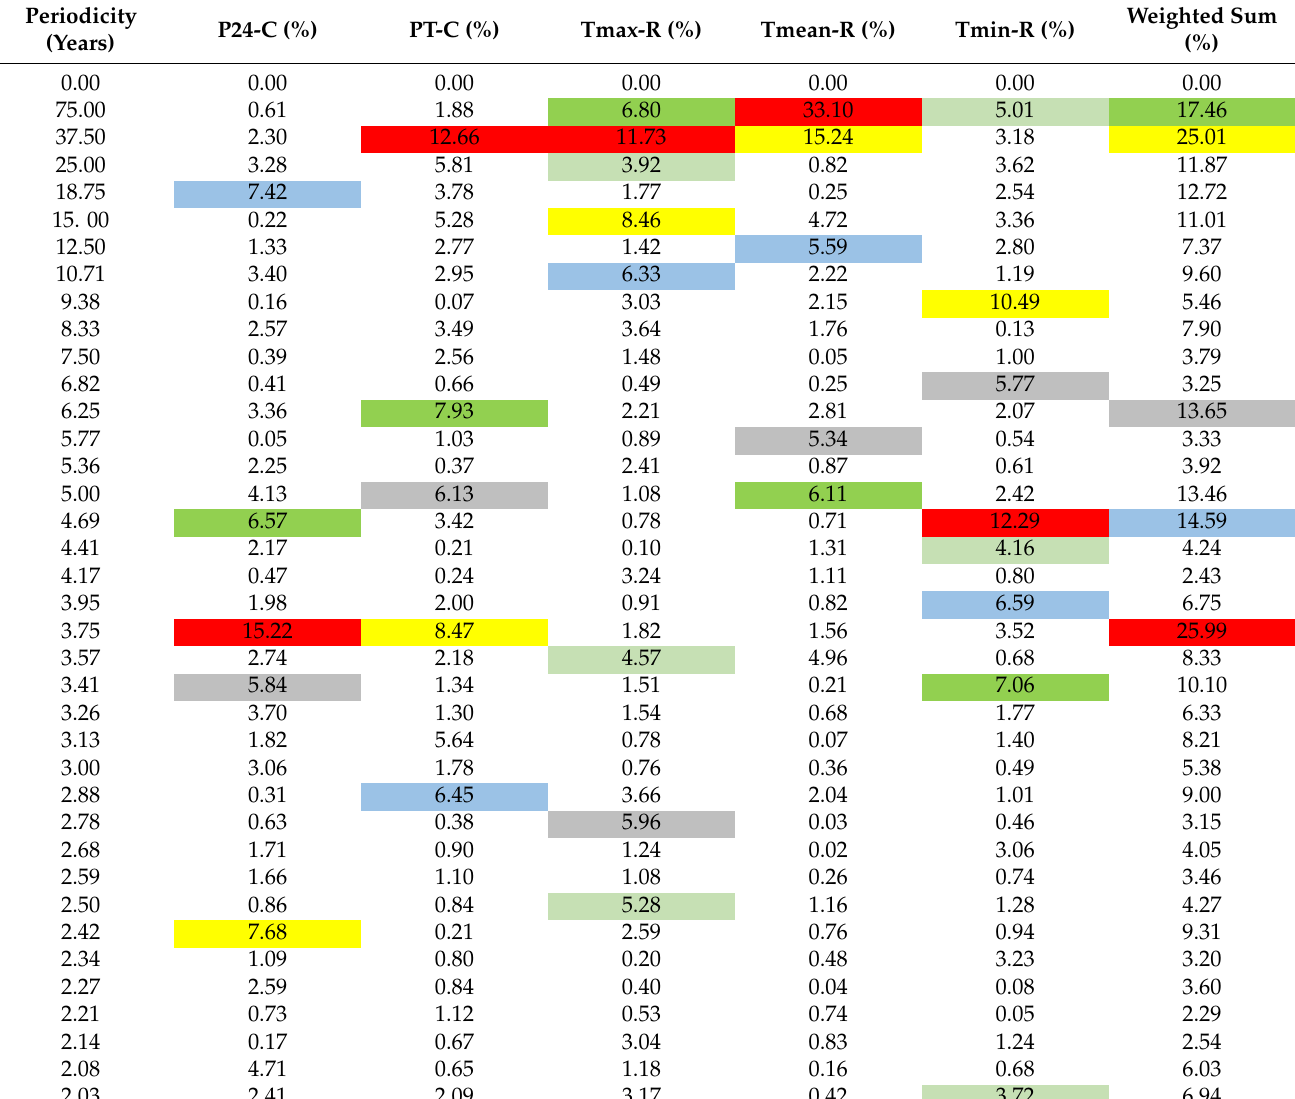
Table 5. Summary of the periodogram resulting from the spectral analysis, expressed as a percentage for each series analyzed (based on XLSTAT